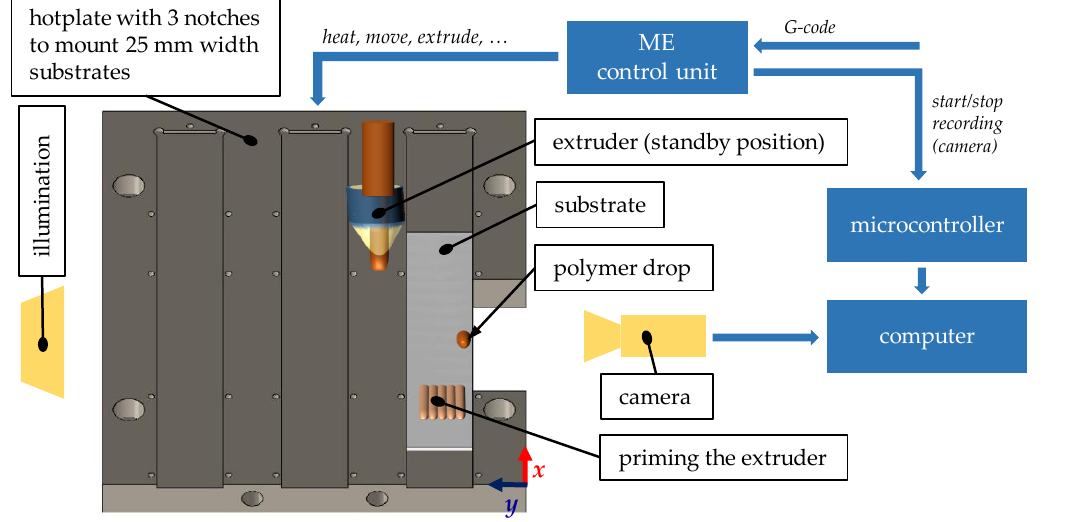
Figure 2. Description of the wetting experiment.